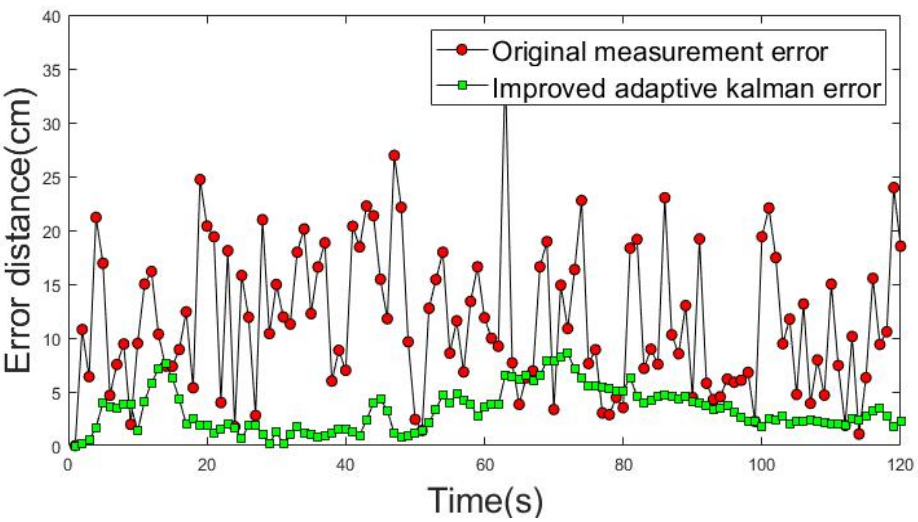
Figure 16. Shift error distance analysis of movement trajectory 2.